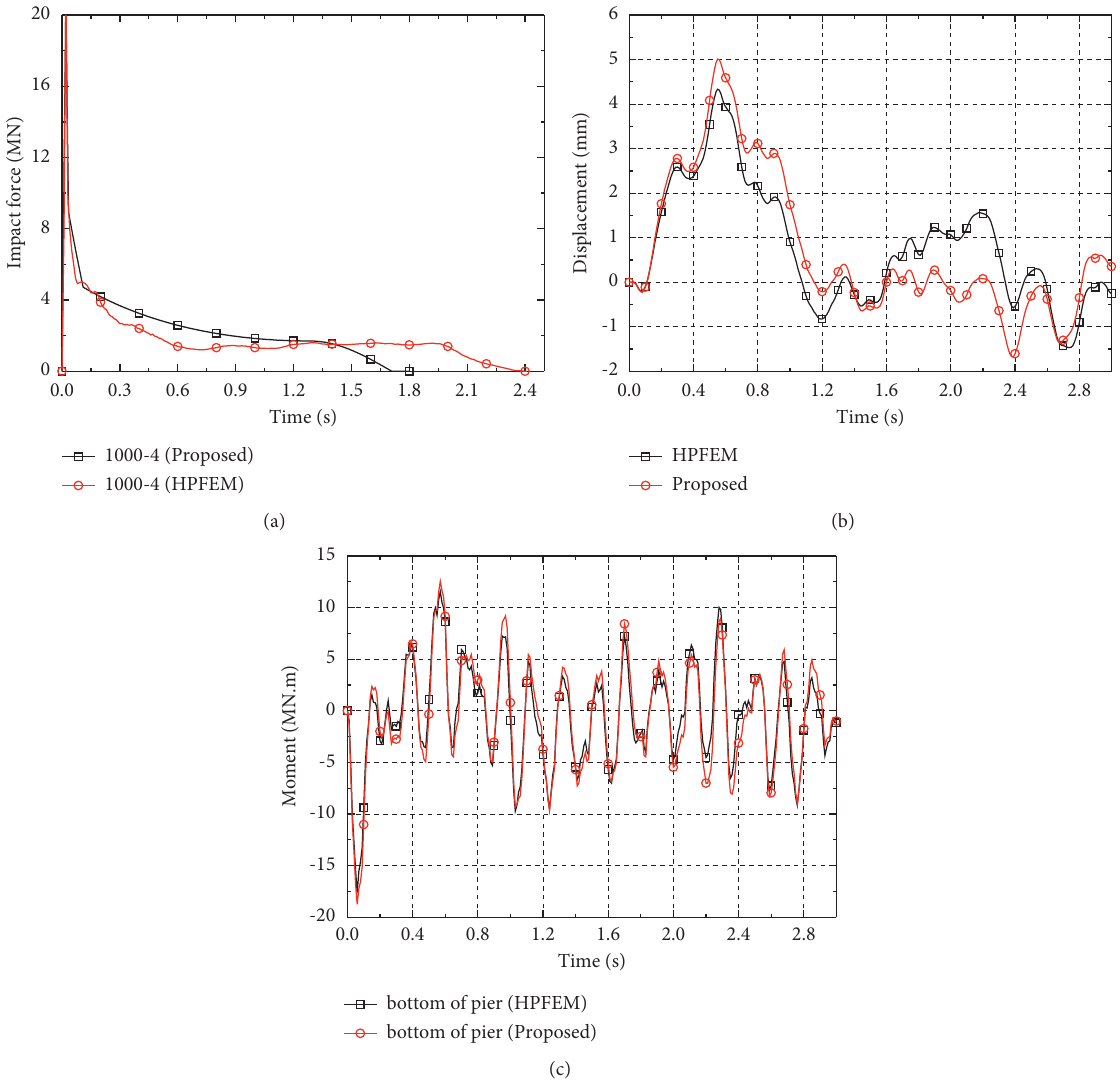
Figure 18: Results of a simulation of a collision by a 1000-ton barge at the impact velocity of 4m/s. (a) Time history of impact force (1000t +4m/s). (b) Time history of displacement of pier top (1000t+4 m/s). (c) Time history of moment of pier bottom (1000t+4